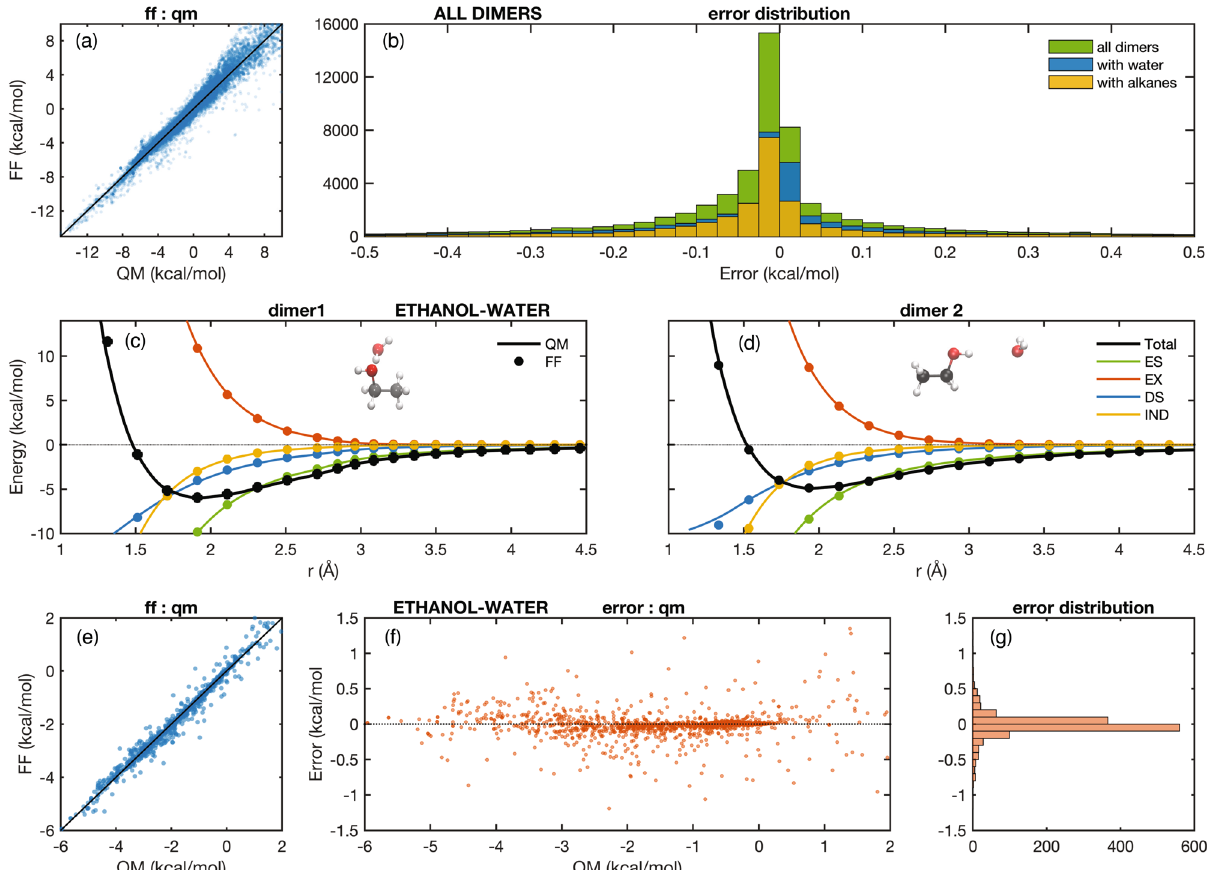
Fig. 1 QM: FF energies ’ correspondences and deviations. a FF vs. QM energies for all the dimers in our training sets. The functional form reproduces the lower energy conformations very well and is designed to permit a larger error in less important high-energy high electron overlap regions. b the distribution of errors for our training dimer sets. The MAE of errors are 0.17 kcal/mol for all, 0.19 kcal/mol for dimers with water (total number of dimers = 36,309), and 0.16 kcal/mol for dimers with alkanes (total number of dimers = 25,986): A speci fi c system (ethanol-water) provides a more detailed illustration of model energies and their correspondence with QM. c , d dissociation curves for primary ( c ) and secondary ( d ) minima of the ethanol-water dimer. QM energies are solid lines and FF values are fi lled circles. The colors designate the energy components: electrostatics (ES), exchange-repulsion (EX), dispersion (DS) and induction (IND). The agreements for the total energy and for each component are excellent. e – g Error distributions for the ethanol- water dimer: e is analogous to a ; f is a difference plot offering a more detailed view and is projected onto ( g ) the error distribution. The MAE for the errors in this system is 0.08